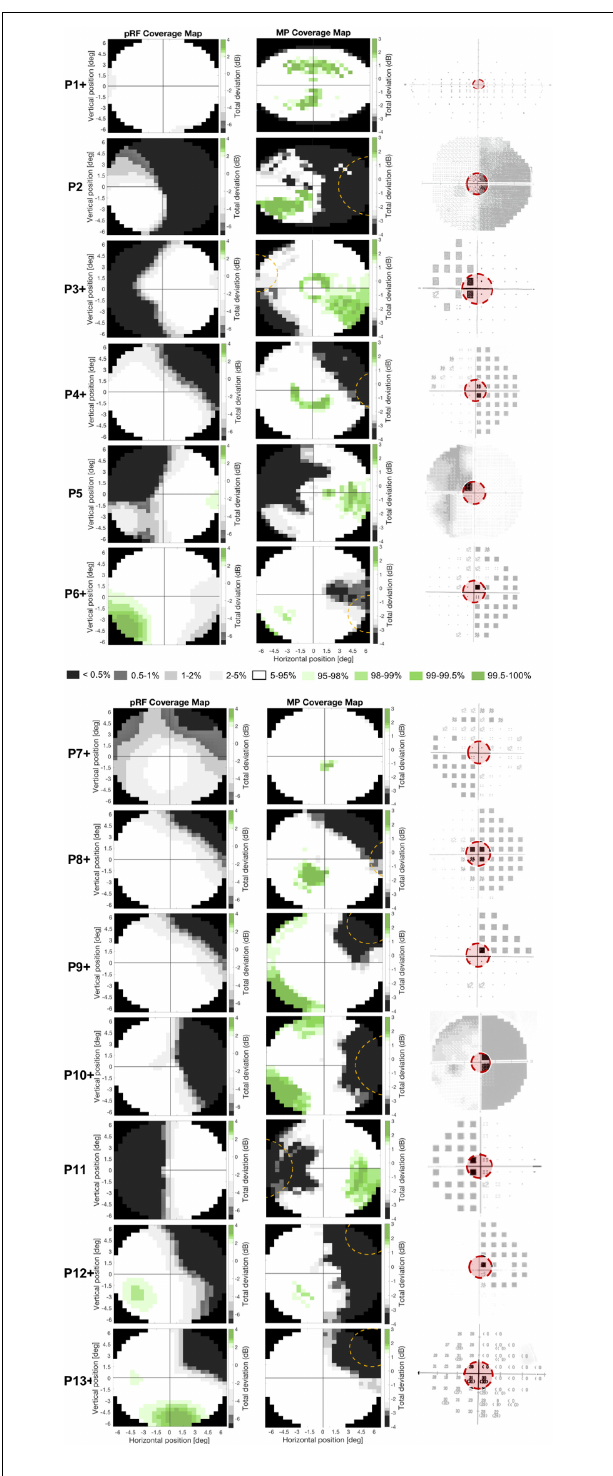
FIGURE 7 | Comparison of the two different fMRI based VF reconstructions to perimetry. Figure shows the pRF- (left column) and MP-based VF reconstruction (middle column) and the perimetric VF (right column) for the thirteen patients. White pRF or MP-based coverage indicate VF sensitivity to be within normal limits (90% CI), the gray and green patches indicate a VF